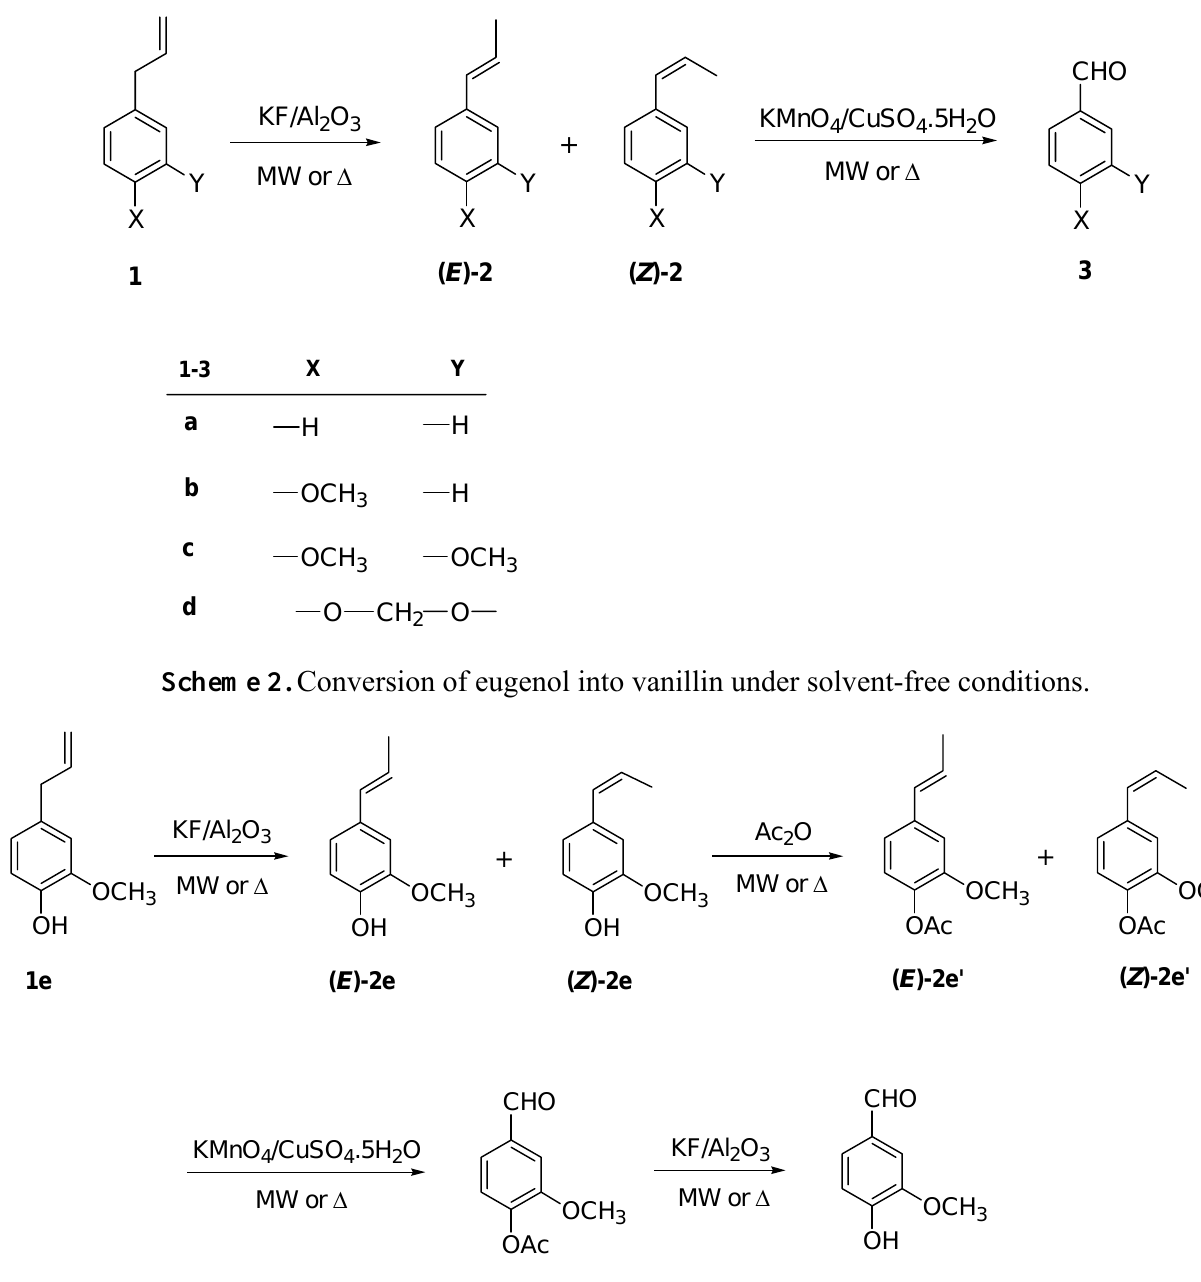
Scheme 1. Conversion of allylbenzenes into the corresponding benzaldehydes under solvent-free conditions.